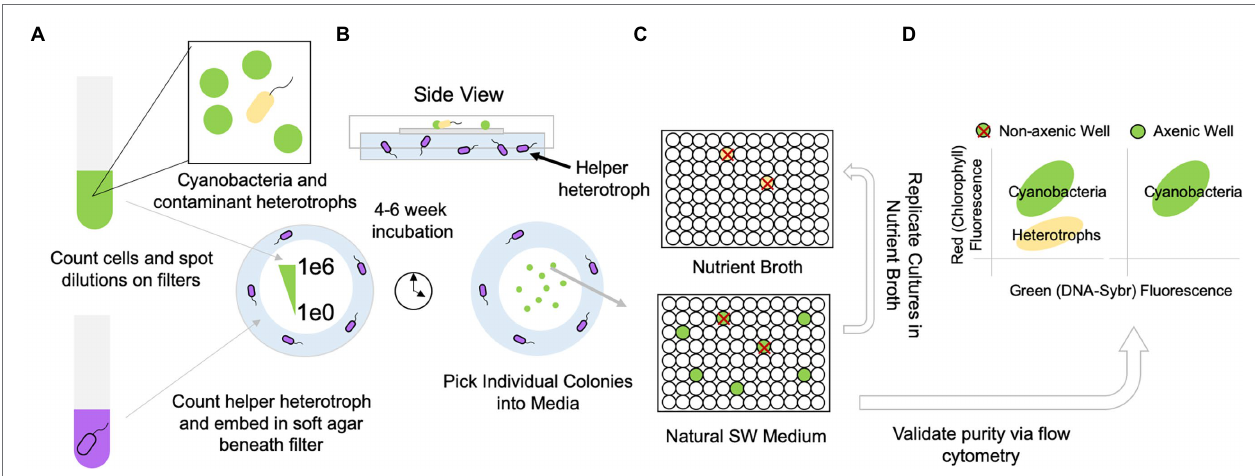
FIGURE 1 | Workflow for obtaining contaminant (yellow)-free, clonal, isolates of Synechococcus and Prochlorococcus (green) by separating helper heterotrophs (purple) from picocyanobacteria using a filter on the surface of the helper cell lawn. (A) Cells of picocyanobacteria and contaminant heterotrophs as well as helper heterotrophs (purple) are counted via flow cytometry; the helper heterotrophs are embedded in a pour plate of cyanobacterial agar. Picocyanobacterial cultures are quantitatively diluted for spotting single cells on overlaid filter membranes. (B) After approximately 4–6 weeks (depending on the strain), colonies derived from single cells appear on filters and are picked into the original cell culture medium (C) plate is replicated (10% transfer) in nutrient broth to verify growth of any contaminant heterotrophs. (D) Cultures without contaminant heterotrophs are further verified via flow cytometry. Axenic cultures are transferred to larger volumes and purity is validated 1–2x more by flow